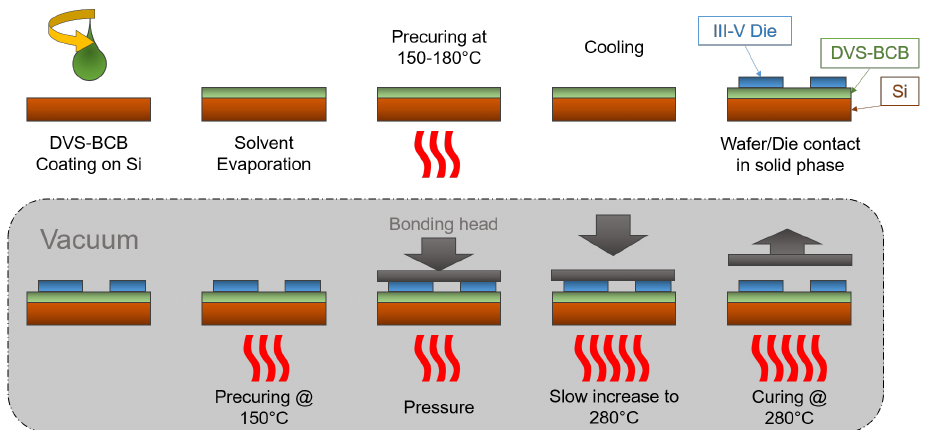
Figure 3. III–V on Silicon bonding process